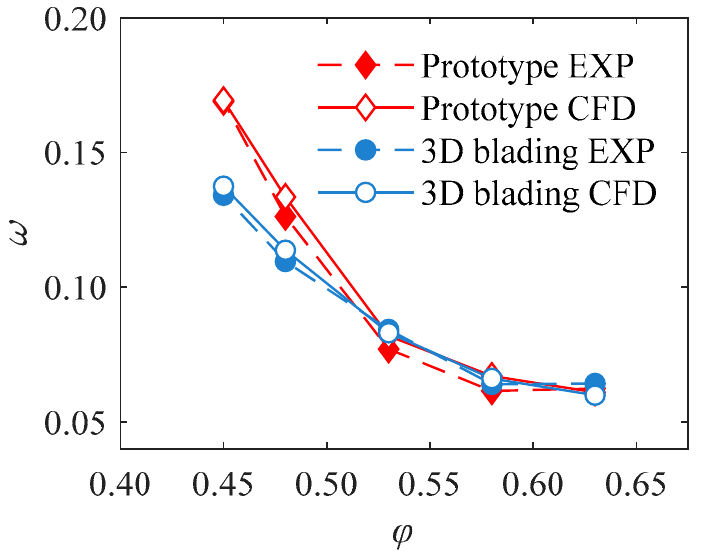
Figure 31. Comparison of loss characteristics of the cantilevered stators between experiment and CFD.